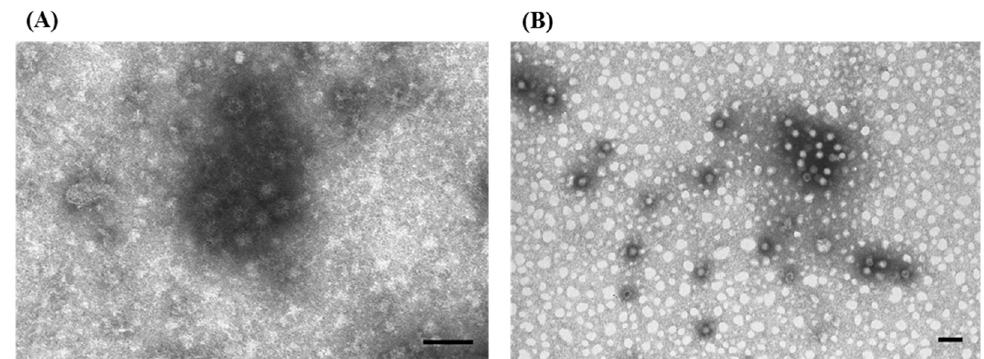
Figure 8. Electron micrograph of ultracentrifuged liver homogenate from rabbits naturally infected with Rabbit Hemorrhagic Disease. The empty icosahedral virions are ~30–32 nm with tiny, short external projections, surrounded by a dense halo of antibodies. ( A ) Immuno-aggregation electron microscopy (IAEM) preparation with a pool of convalescent sera diluted 1:40 from experimentally infected rabbits that survived the infection. Negative staining (2% sodium phosphotungstate). TEM Philips CM10, 80 kV. Bar = 100 nm; ( B ). IAEM negative control: RHDV particles are distributed singly or in small spontaneous groups.